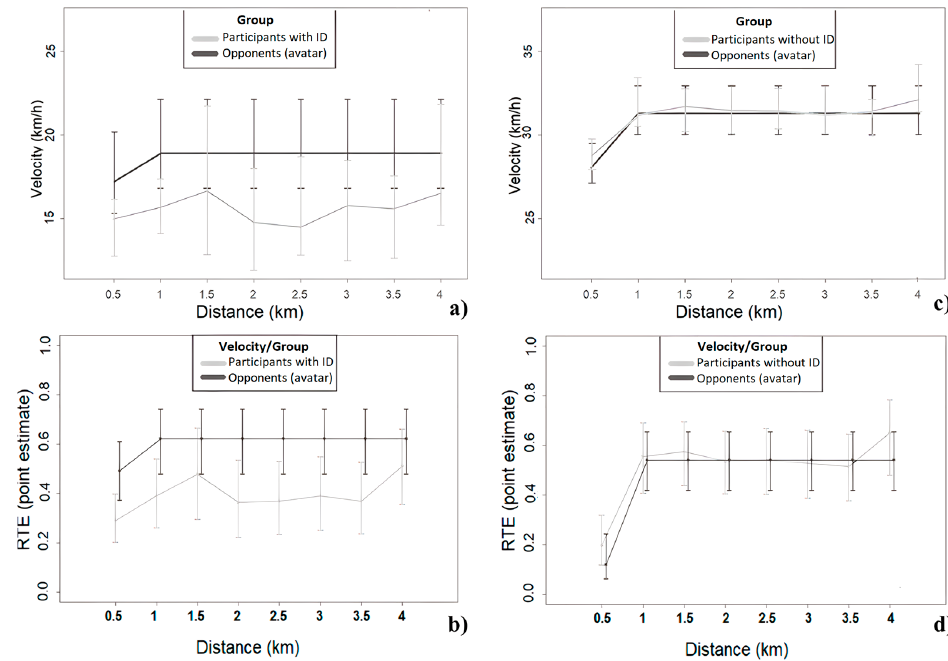
Figure 4. Line graphs with the median velocity differences (+ interquartile ranges) and the relative effects (+ 95% confidence intervals) in the ‘against an opponent’ condition between the participants with ( a , b ) and without ID ( c , d ) and their virtual opponents (avatars).